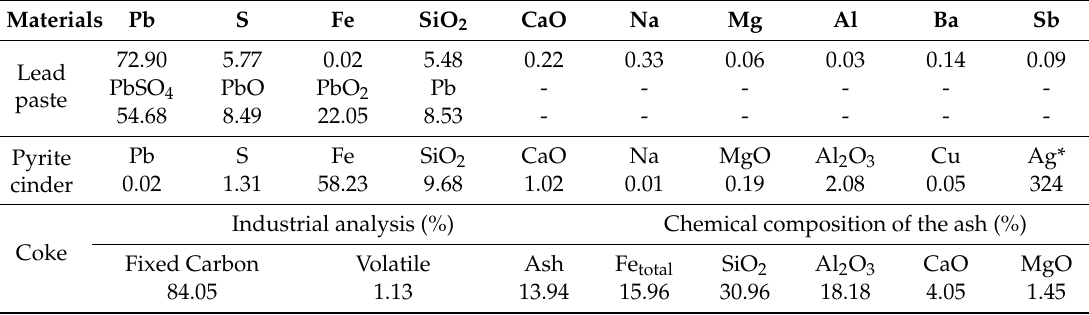
Table 1. Chemical composition of the corresponding materials (wt.%), * g/t.